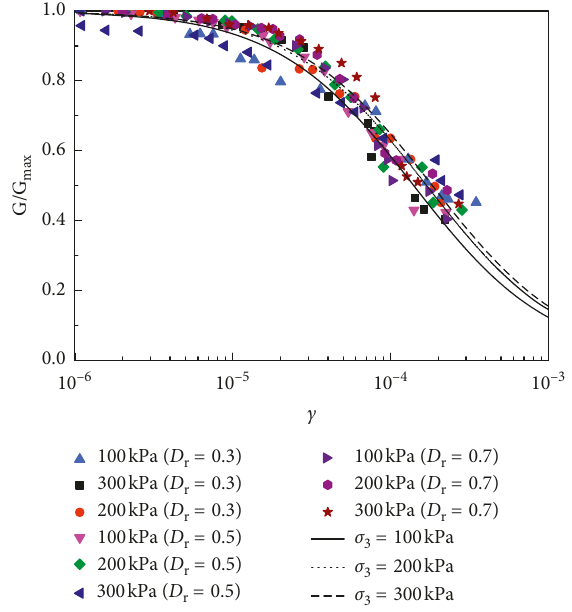
c under different confining max -